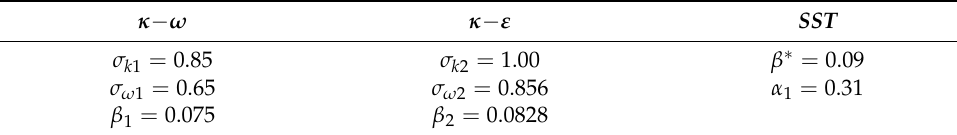
Table 2. Closure constants of the k − ω − SST